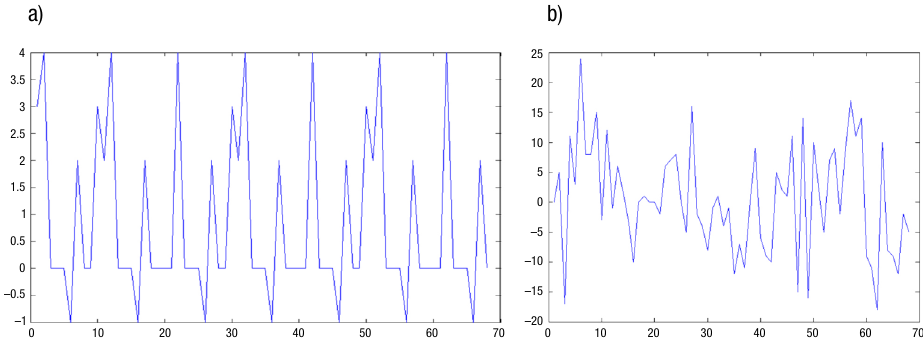
Fig. 9. Artificial periodical development (detail) (a), “hidden’’ in the development (b), source: own research